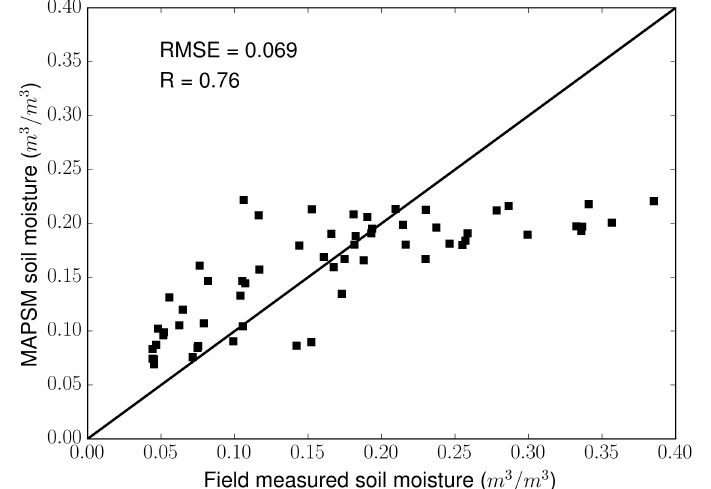
Figure 22. Comparison of the MAPSM soil moisture with the field measured soil moisture at the spatial resolution of 500 m for the entire study